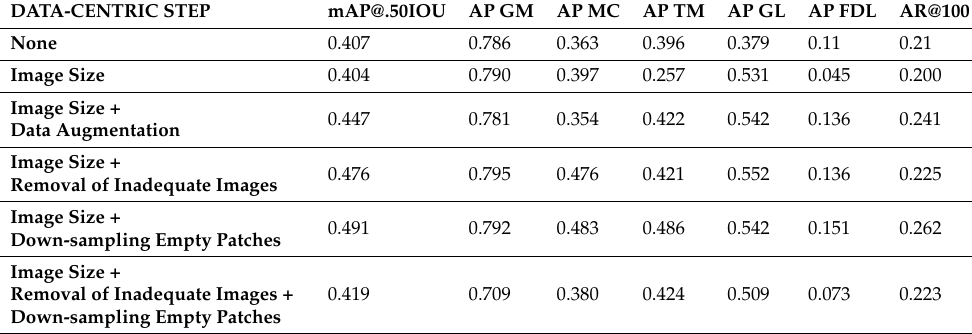
Table 5. Data-centric results for Faster R-CNN ResNet101.